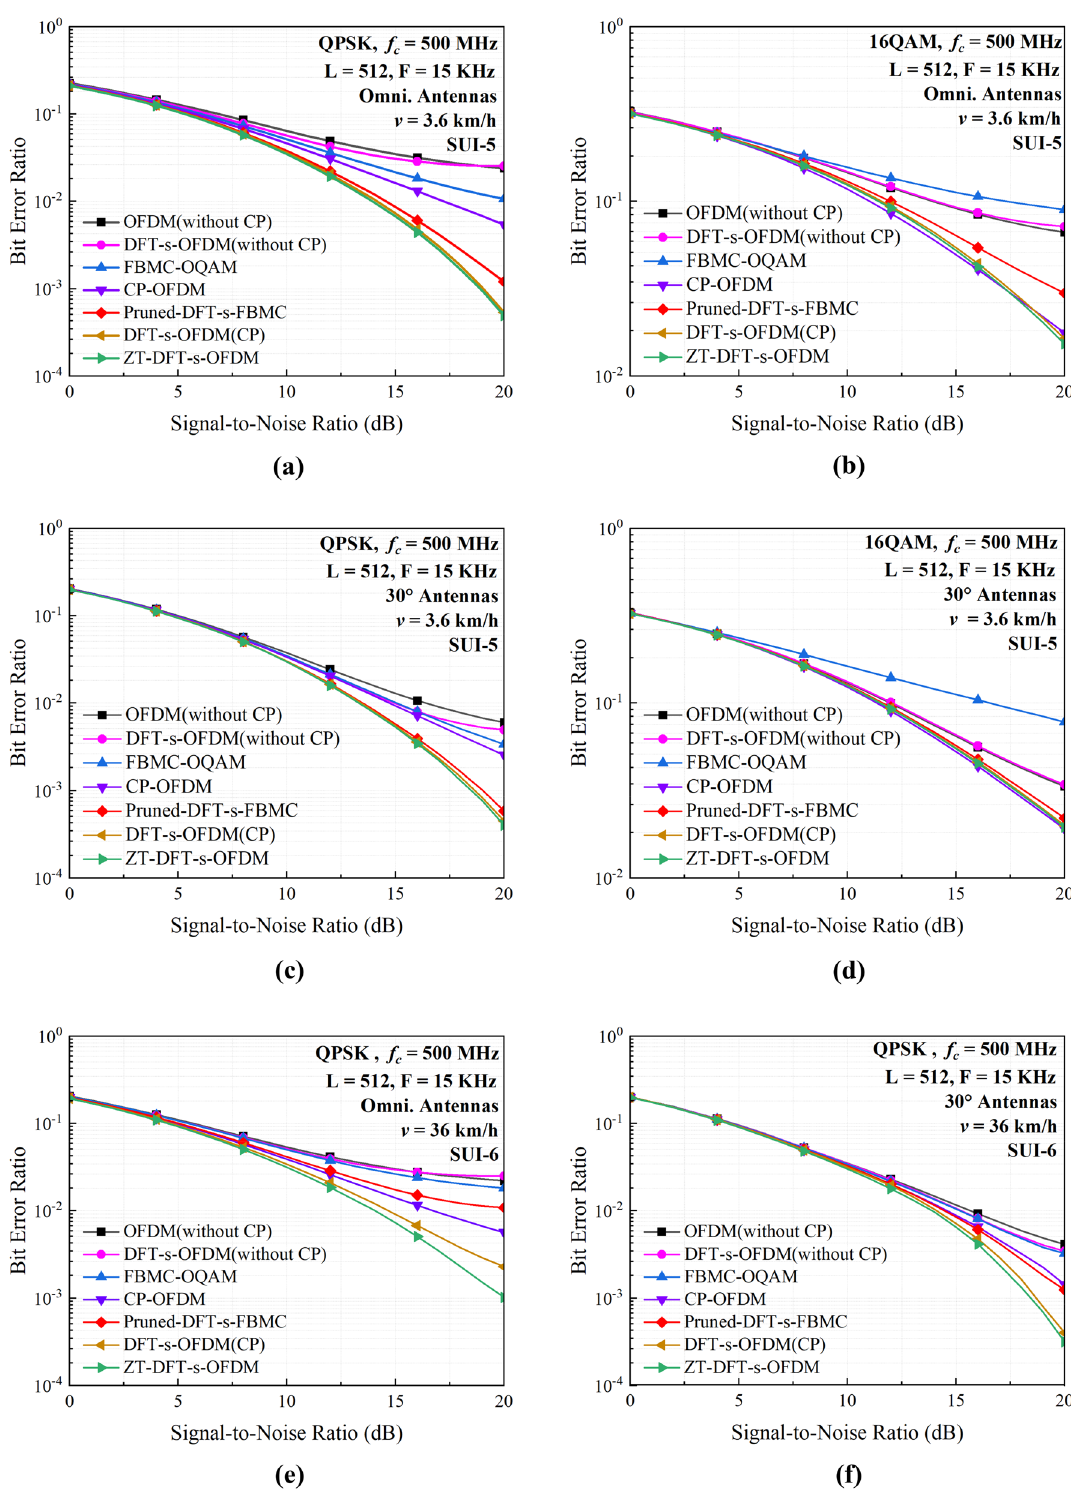
Figure 6. Simulated BER performance for different multi-carrier schemes under different conditions. For a fair comparison, we set the carrier frequency f c , the subcarrier spacing F and the subcarrier number L to constant values. ( a,b ) Are the BER performance for QPSK and 16QAM modulations under the SUI-5 channel using the omnidirectional antenna, respectively. ( c,d ) are the BER performance for QPSK and 16QAM modulations under the SUI-5 channel using the 30° directional antenna, respectively. ( e,f ) Are the BER performance for QPSK modulation under the SUI-6 channel, using the omnidirectional and directional antennas,